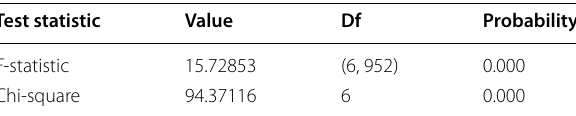
Table 7 Wald test for joint significance. Source: Researcher’s compilation (2022)